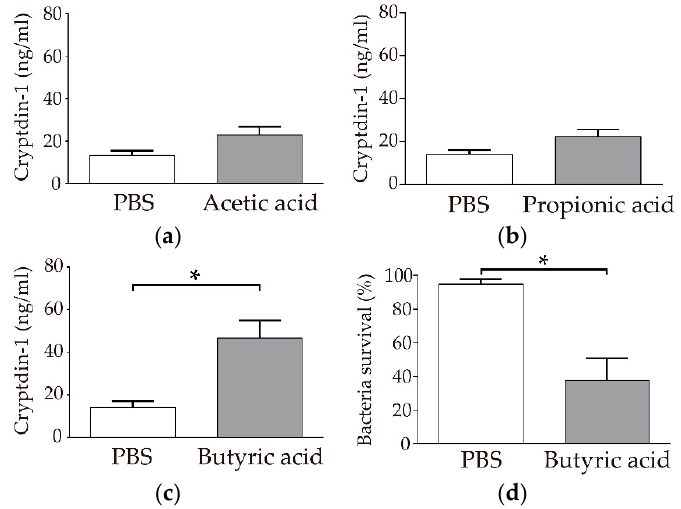
Figure 1. Induction of Cryptdin-1 (Crp1) secretion from Paneth cells by short-chain fatty acids using isolated crypts of the mouse small intestine: Induction of Crp1 secretion by Paneth cells in response to 100 µM ( a ) Acetic acid, ( b ) propionic acid, and ( c ) butyric acid. Data are expressed as the means ± SEM ( n = 5). * p < 0.05 by Student’s t- test. ( d ) Bactericidal activities of Paneth cell secretions stimulated by butyric acid and PBS control against S. typhimurium . Data are expressed as the means ± SEM ( n = 3). * p < 0.05 by Student’s t -test.